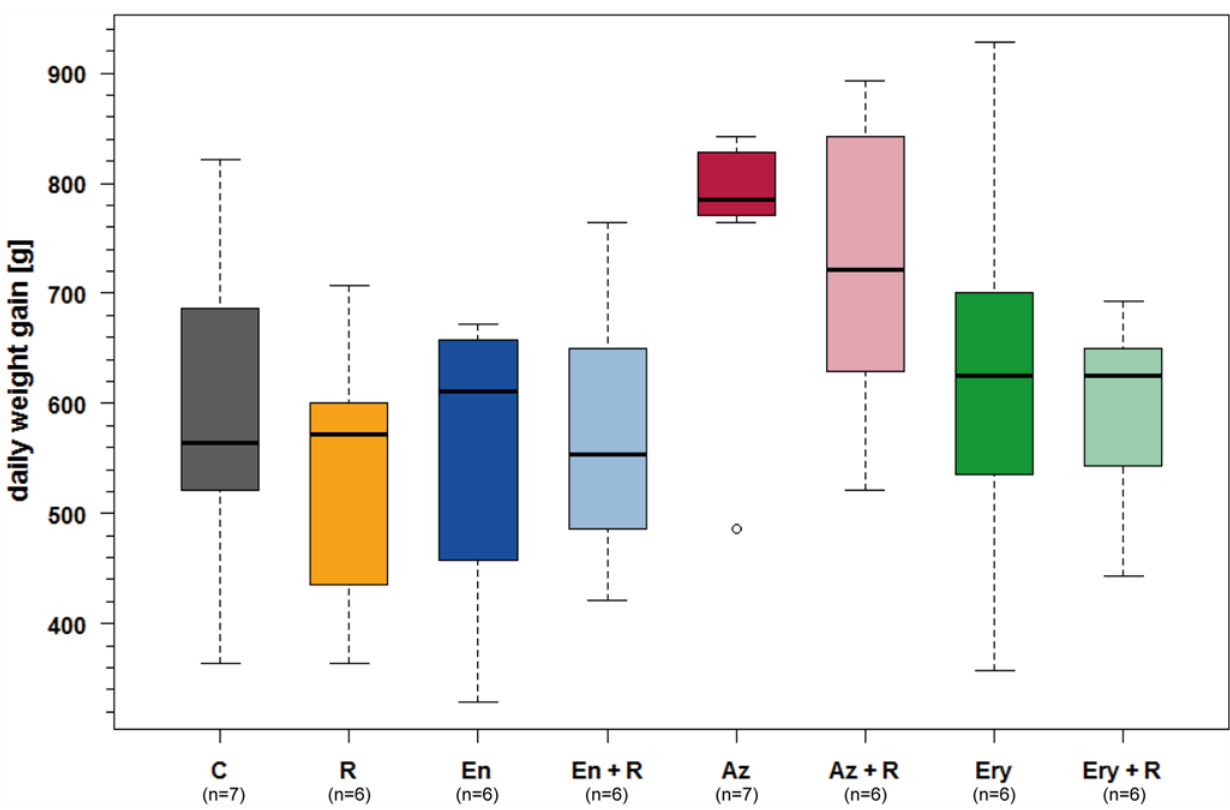
Fig 3. Daily weight gain. Daily weight gain was highest in azithromycin treated animals, but the difference compared to untreated controls was not statistically significant (many-to-one comparisons by Gao et al . (2008) with Hochberg-adjustment, P > 0.47). C: untreated controls, R: rifampicin,